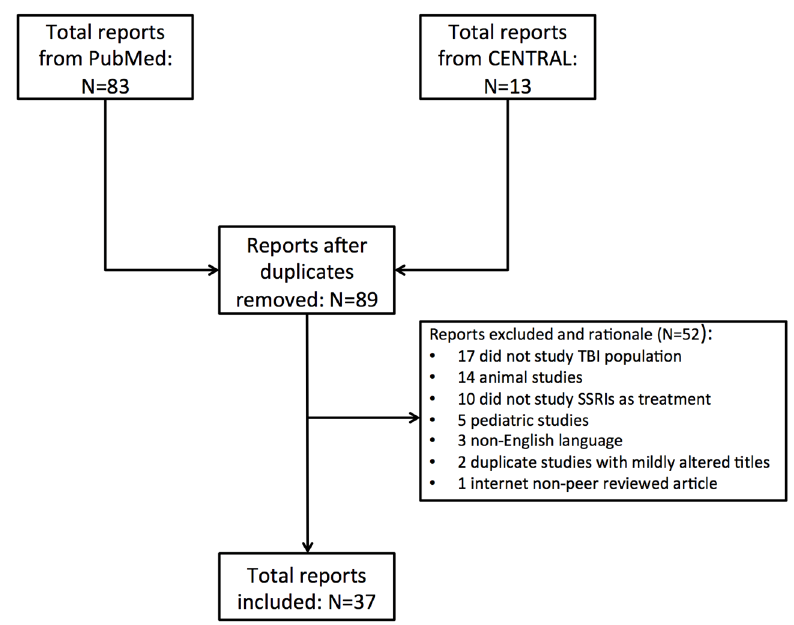
Figure 1. Flowchart of included studies. CENTRAL, Cochrane Central Register for Controlled Trials; SSRI, selective serotonin reuptake inhibitor; TBI, traumatic brain injury.